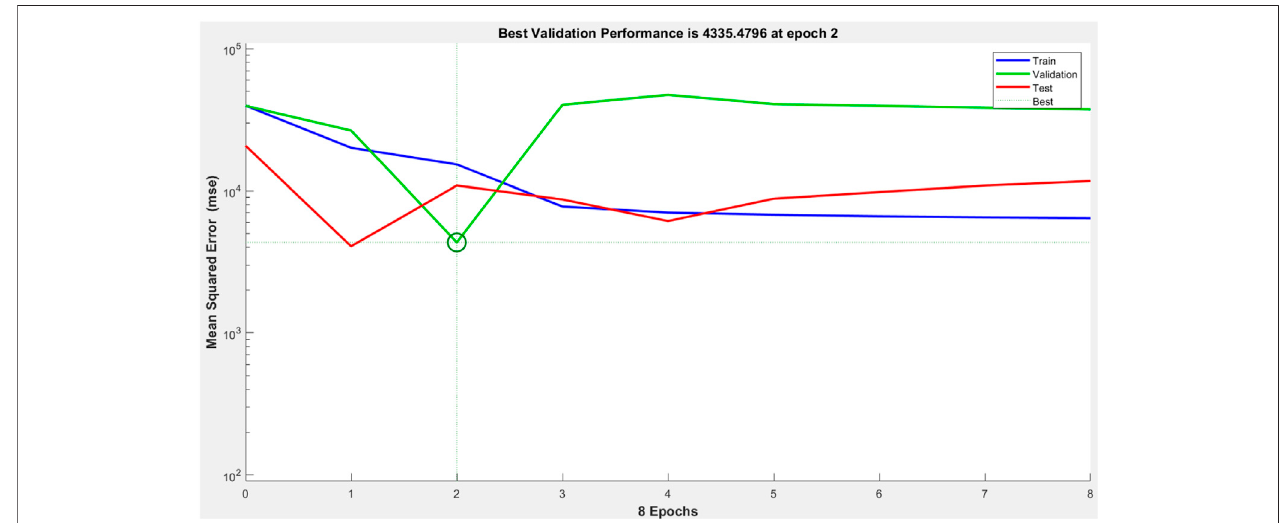
FIGURE 7 | The performance of the designed ANN model.